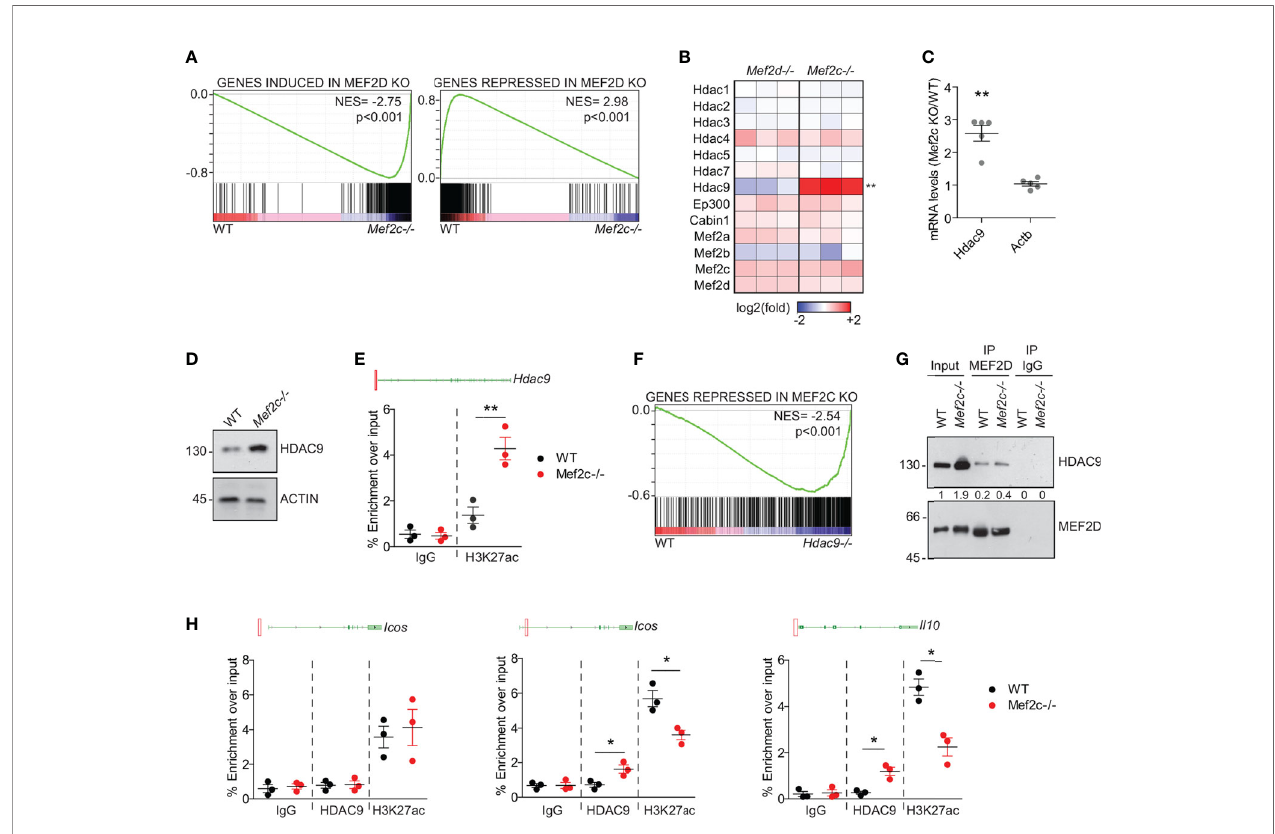
FIGURE 3 | Mef2c depletion switches on Hdac9 transcription and triggers a feedback response that limits the transcriptional activity of Mef2d. (A) GSEA plots obtained by using the transcripts signi fi cantly induced (left) or repressed (right) in Mef2d-/- Tregs (18) as gene-sets and the transcriptome of WT or Mef2c-/- Tregs as dataset. (B) Heat-map representing the z-scores of the indicated transcripts in Mef2d-/- and Mef2c-/- Tregs in respect to WT Tregs. (C) mRNA expression levels of the indicated genes, expressed as a ratio between Mef2c-/- and WT Tregs (t-test between the two groups for each gene, n = 5, **p < 0.01). (D) Immunoblot analysis of HDAC9 in WT and Mef2c-/- Tregs, as indicated. Actin was used as loading control. (E) Histogram representing the qPCR results obtained in freshly isolated WT and Mef2c-/- Tregs after the ChIP with H3K27ac or IgG antibodies. Above the histogram we included the representation of the genomic locus of Hdac9. The red square indicates the position of the ampli fi ed region in respect to the leading TSS (n = 3, **p < 0.01). (F) GSEA plot obtained by using the transcripts signi fi cantly repressed in Mef2c-/- Tregs as gene-set and the transcriptome of WT or Hdac9-/- Tregs (33) as dataset. (G) Lysates from freshly isolated WT or Mef2c-/- Tregs were pulled down with anti-Mef2or IgG Ab (1 m g). 1/50 total lysates have been included and marked as input. (H) Histogram representing the qPCR results obtained in freshly isolated WT and Mef2c-/- Tregs after the ChIP with the indicated antibodies. For each gene analyzed, we included the illustration of the genomic locus in which the red squares point to the position of the ampli fi ed region in respect to the leading TSS (n = 3, *p <